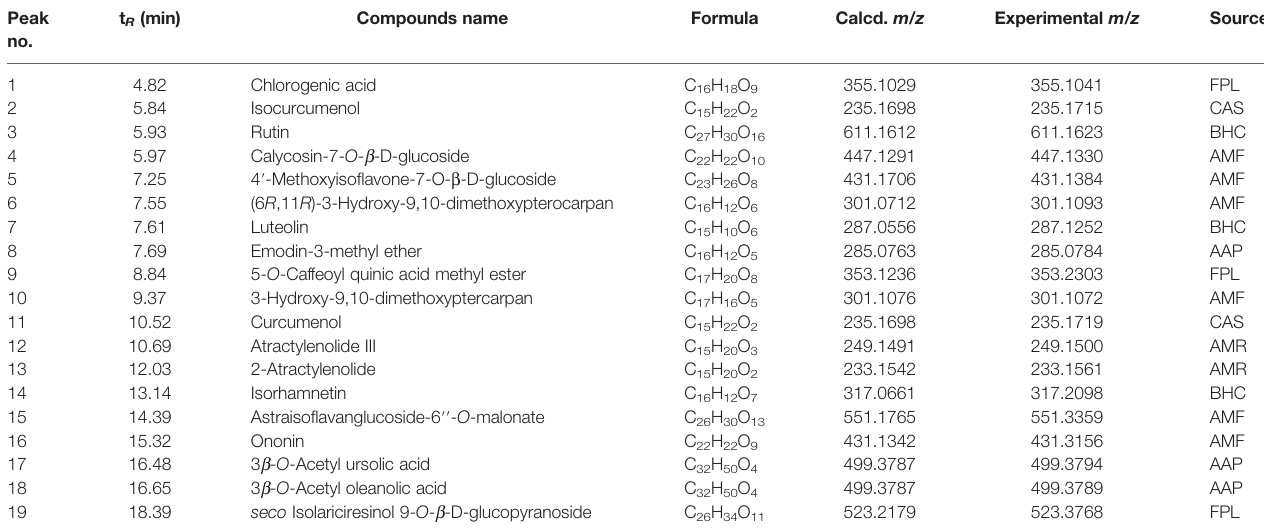
TABLE 3 | HPLC Q-TOF/MS analysis results for chemical contents in the ethanol extract of AAM (positive ions). Peak t R no.